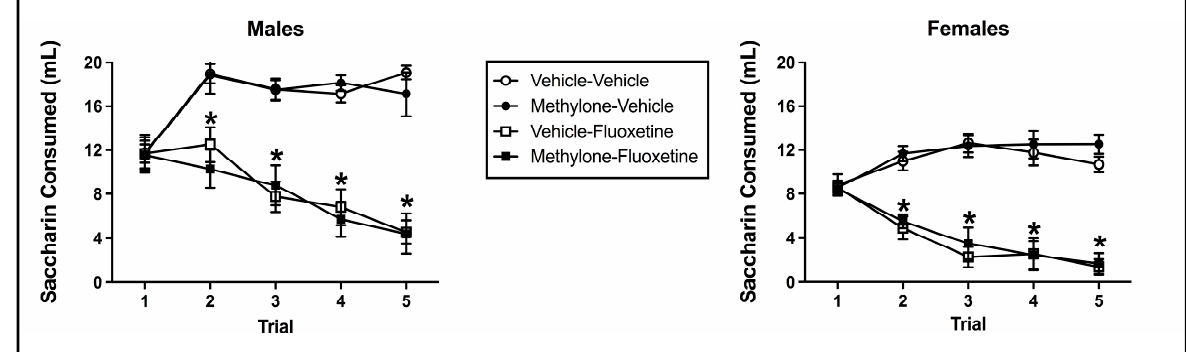
Figure 3. Mean (+/ − SEM) saccharin consumption (mL) during taste avoidance conditioning by male ( left ) and female ( right ) subjects injected with saline (vehicle) or methylone during pre-exposure and conditioned with vehicle or 10 mg/kg of fluoxetine ( n = 8–9 per group for both males and females). * Subjects conditioned with fluoxetine (regardless of pre-exposure condition) significantly differed from controls.